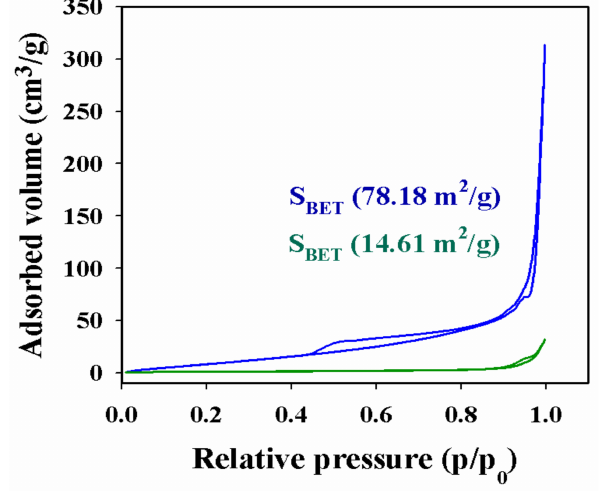
Figure 4. The BET analysis of Pt-NPs-embedded PPy-CB@ZnO NCs (blue line) and ZnO (green line).